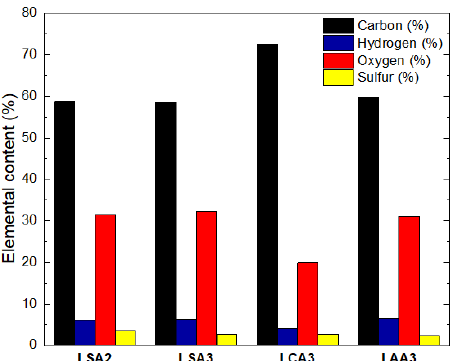
Figure 8. Effect of Acid Type on Ultimate Analysis of LSA2, LSA3, LCA3, and LAA3. The percentage of hydrogen and oxygen contained in LCA3 was lower than LSA2, LSA3, and LAA3. This was probably because citric acid had a better ability to dissolve impurities and consisted of various polysaccharide degradation products that had a high amount of hydrogen and oxygen in their structures. To confirm this hypothesis, FTIR characterization was conducted to evaluate functional groups present in the samples. FTIR spectra of the lignin samples are presented in Figure 9. The absorbance pattern of the FTIR spectrum represents the vibrational modes of the samples. The samples showed a broad band centered at 3400 cm − 1 , which attributed to the O-H stretching vibration in lignin. The band around 2900 cm − 1 and 2850 cm − 1 indicated the vibration of C-H stretching in the methyl and methylene group, respectively. The band around 1700 cm − 1 was assigned to the vibration of C=O stretching. The 1600 cm − 1 , 1512 cm − 1 , and 1450 cm − 1 bands indicated the C=C stretching in aromatic ring. The result showed that LCA3 had a higher number of aromatic groups, as compared to LSA3 and LAA3. On the other hand, the lignin purity of LCA3 was lower than LSA3 but was slightly higher than LAA3. This proved that some of the aromatic rings contained in LCA3 were not aromatic rings that made up lignin. These aromatic groups were probably impurities resulting from the degradation of lignin, such as phenols and several other aromatic derivatives. The C-O stretching of syringil, guacyl, and phenolic groups could be indicated by peaks at 1327 cm − 1 , 1267 cm − 1 , and 1215 cm − 1 , respectively. The absorbance peak in 1100 cm − 1 and 1035 cm − 1 indicated the C-H deformation of the aromatic ring and C-O stretching in secondary alcohol.